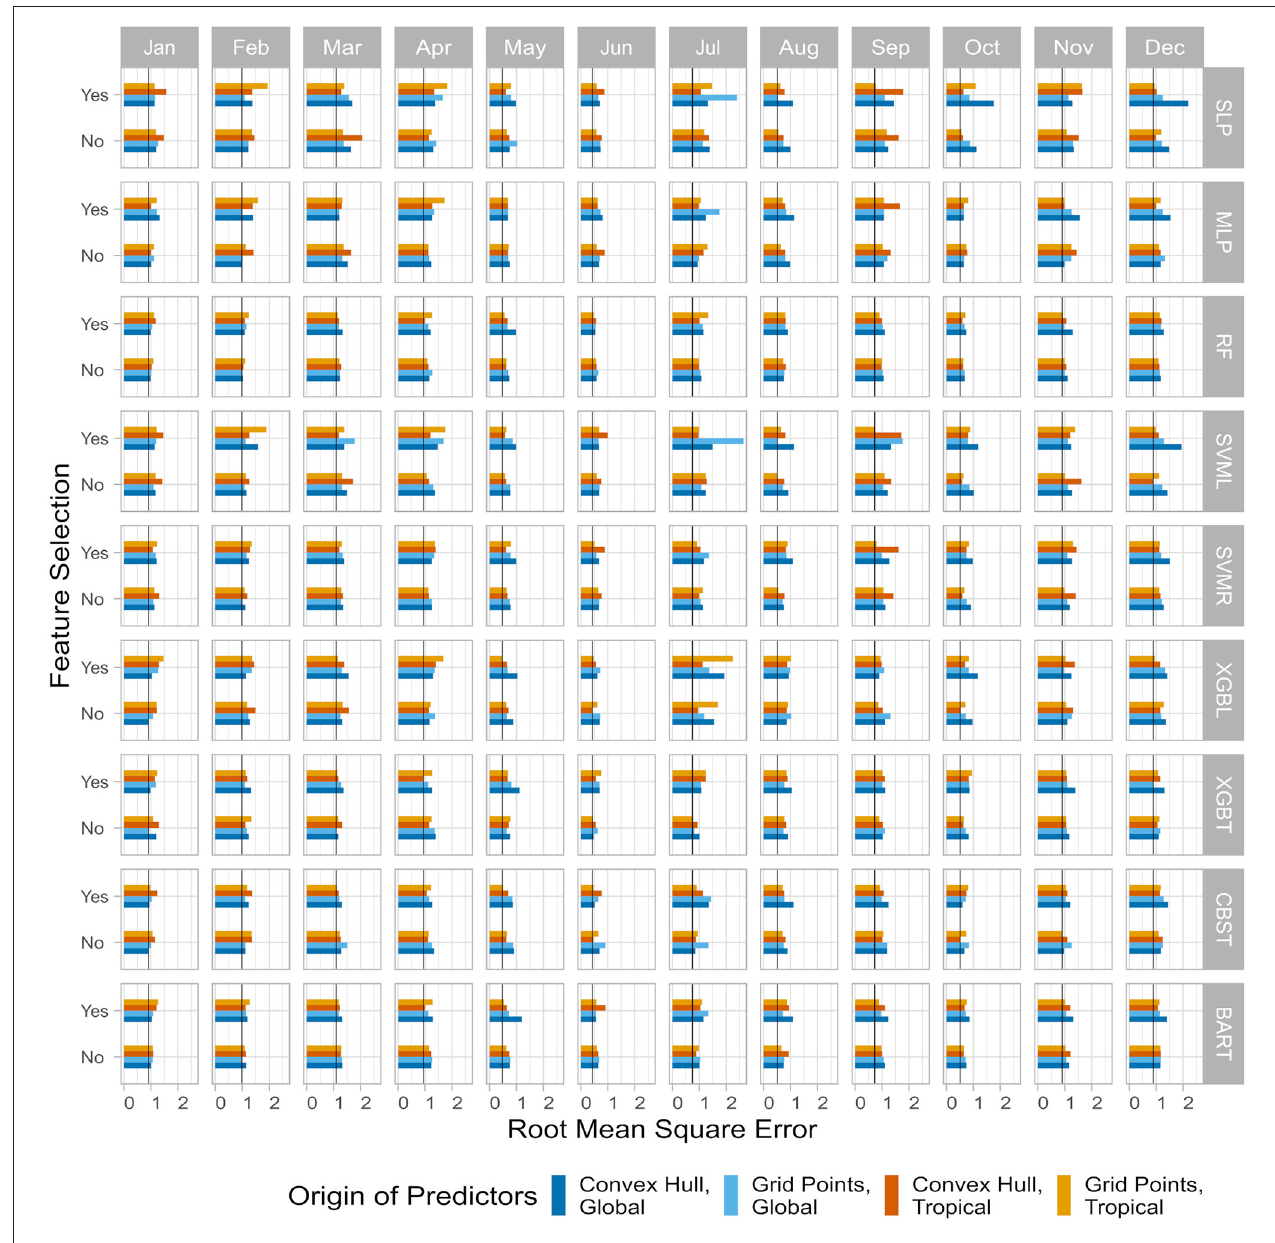
FIGURE 6 | Same as Figure 5 but for the root mean square error